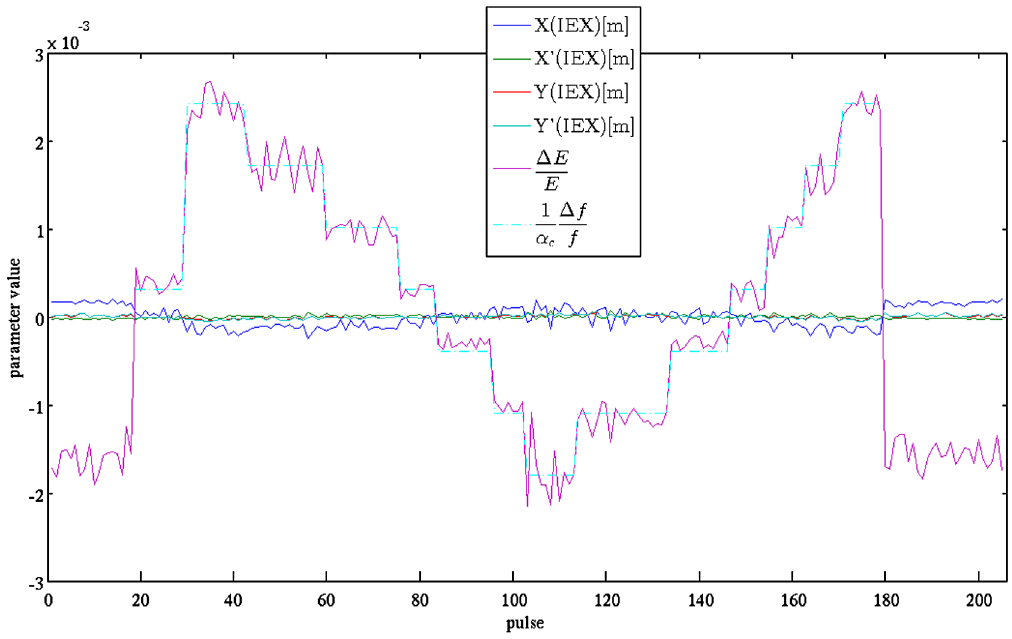
FIG. 3. Reconstruction of the parameters at the injection point during a dispersion